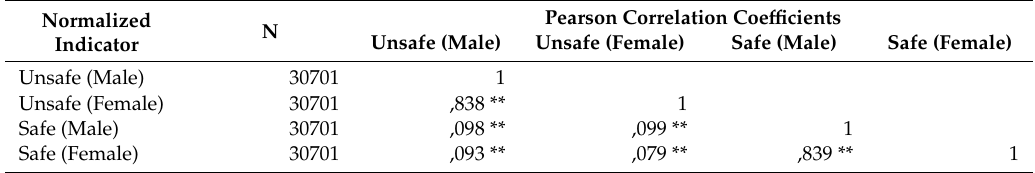
Table 2. Grid level correlation between male and female respondents’ markings of safety and unsafety. Normalized